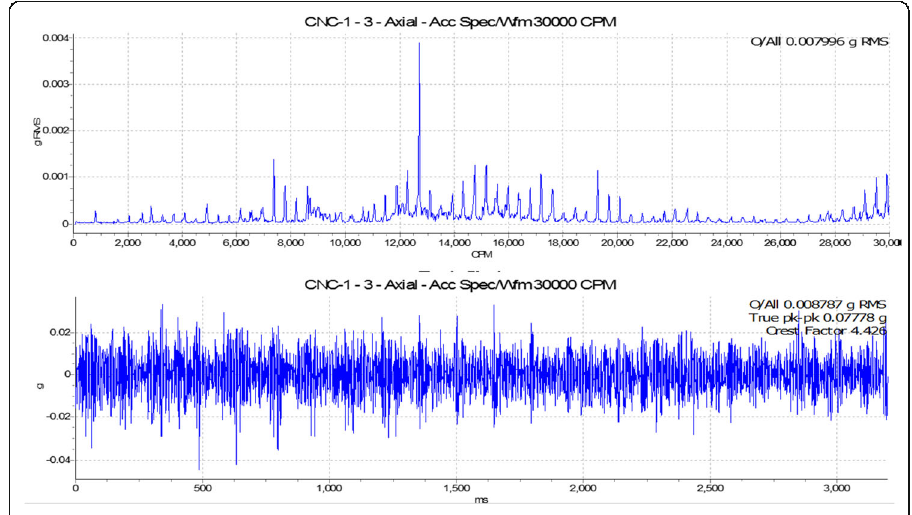
Fig. 8 Test condition (TC9) for tool